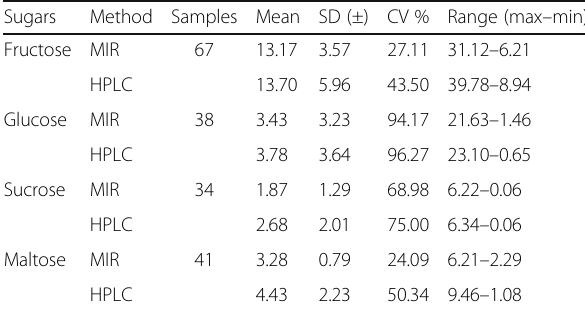
Table 1 Means, ranges, and SD of mango samples used in calibration and cross-validation